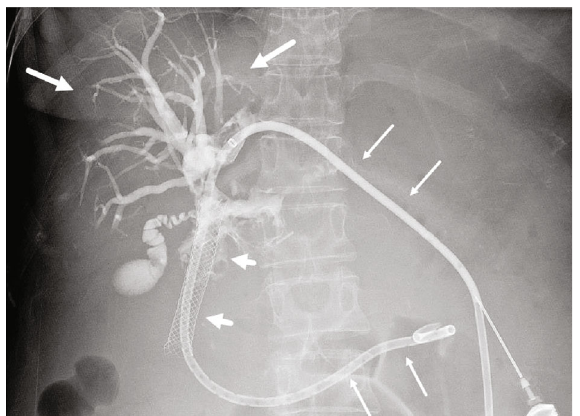
Figure 1: Contrast cholangiography via internal-external biliary drainage catheter (long arrows) demonstrates intrahepatic biliary ductal dilatation (large arrows). There is an occluded metal stent (arrowheads) with no fl ow of contrast beyond this point into the bowel.